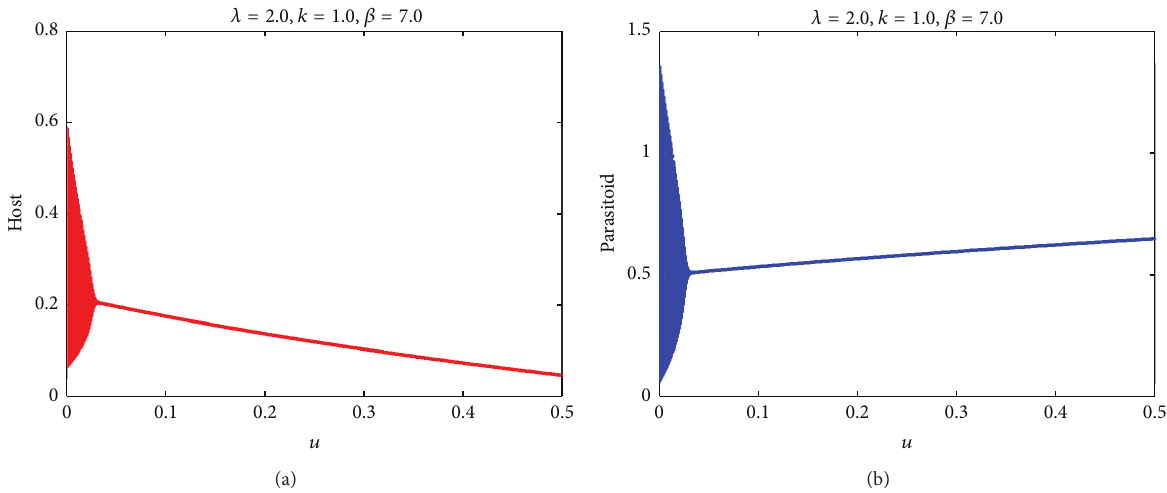
Figure 2: Bifurcation diagrams for system (15) with a Beverton-Holt growth rate. Parameter values are 𝜆 = 2 , 𝑘 = 1 , and 𝛽 = 7